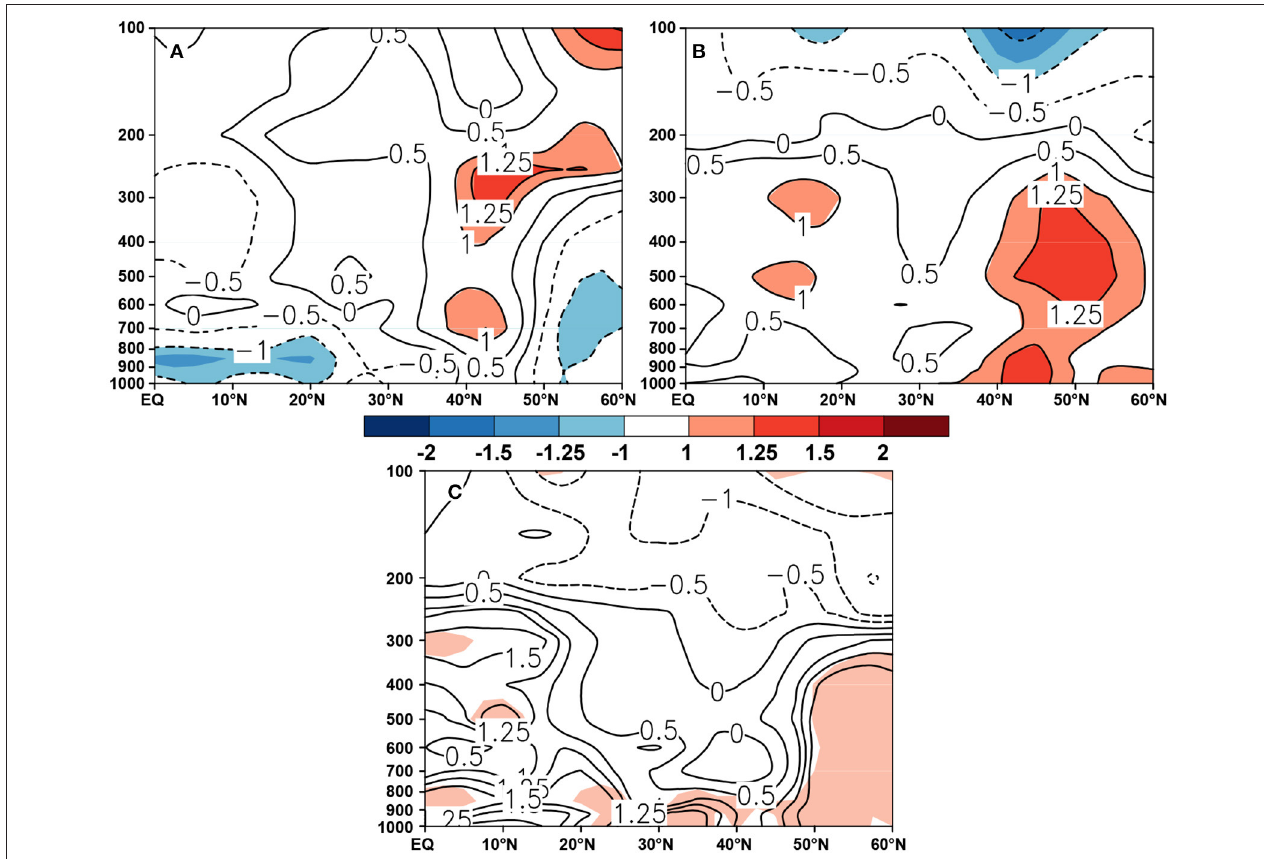
FIGURE 2 | Latitude–height profile of normalized temperature average of extremely warm years over 110–120 ◦ E in (A) the cold period and (B) the warm period, and (C) the difference of the warm period minus the cold period (contour: mean temperature anomalies; shading areas indicate the 90% significance